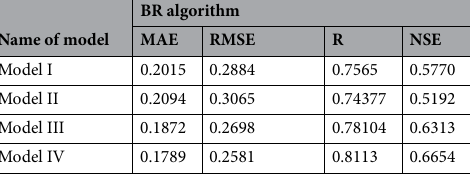
Table 15. MAE, RMSE, MSE, R and NSE values of each model trained with